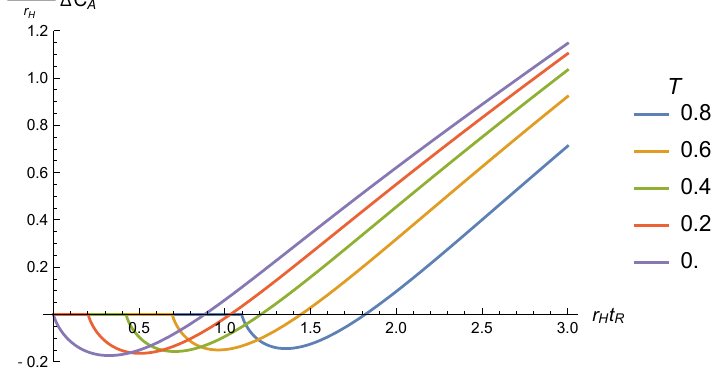
Figure 27 . The regularized complexity during phases ii and iii, as a function of boundary time, for a selection of di(cid:11)erent brane tensions, T